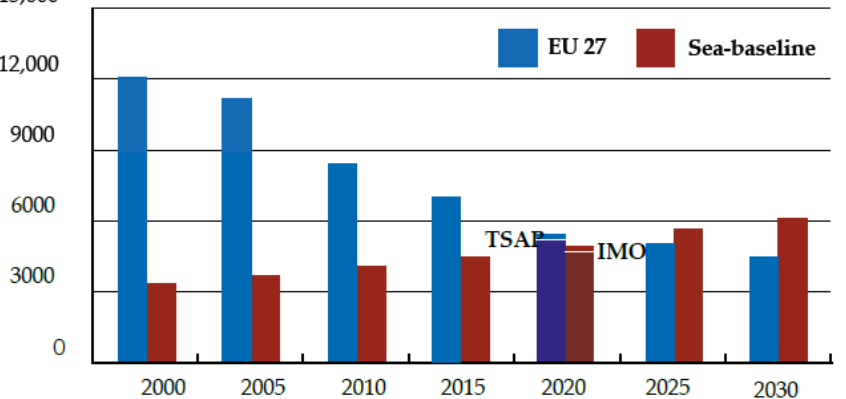
Figure 1. Emissions of NO x from 2000 to 2030 (tons) [1]. SEU27 = Emissions from land-based sources (incl. domestic shipping): Sea—emissions from international shipping in European sea areas; TSAP—target in line with the EU’s Thematic Strategy on Air Pollution; IMO—expected outcome from implementing the revised IMO MARPOL Annex VI.